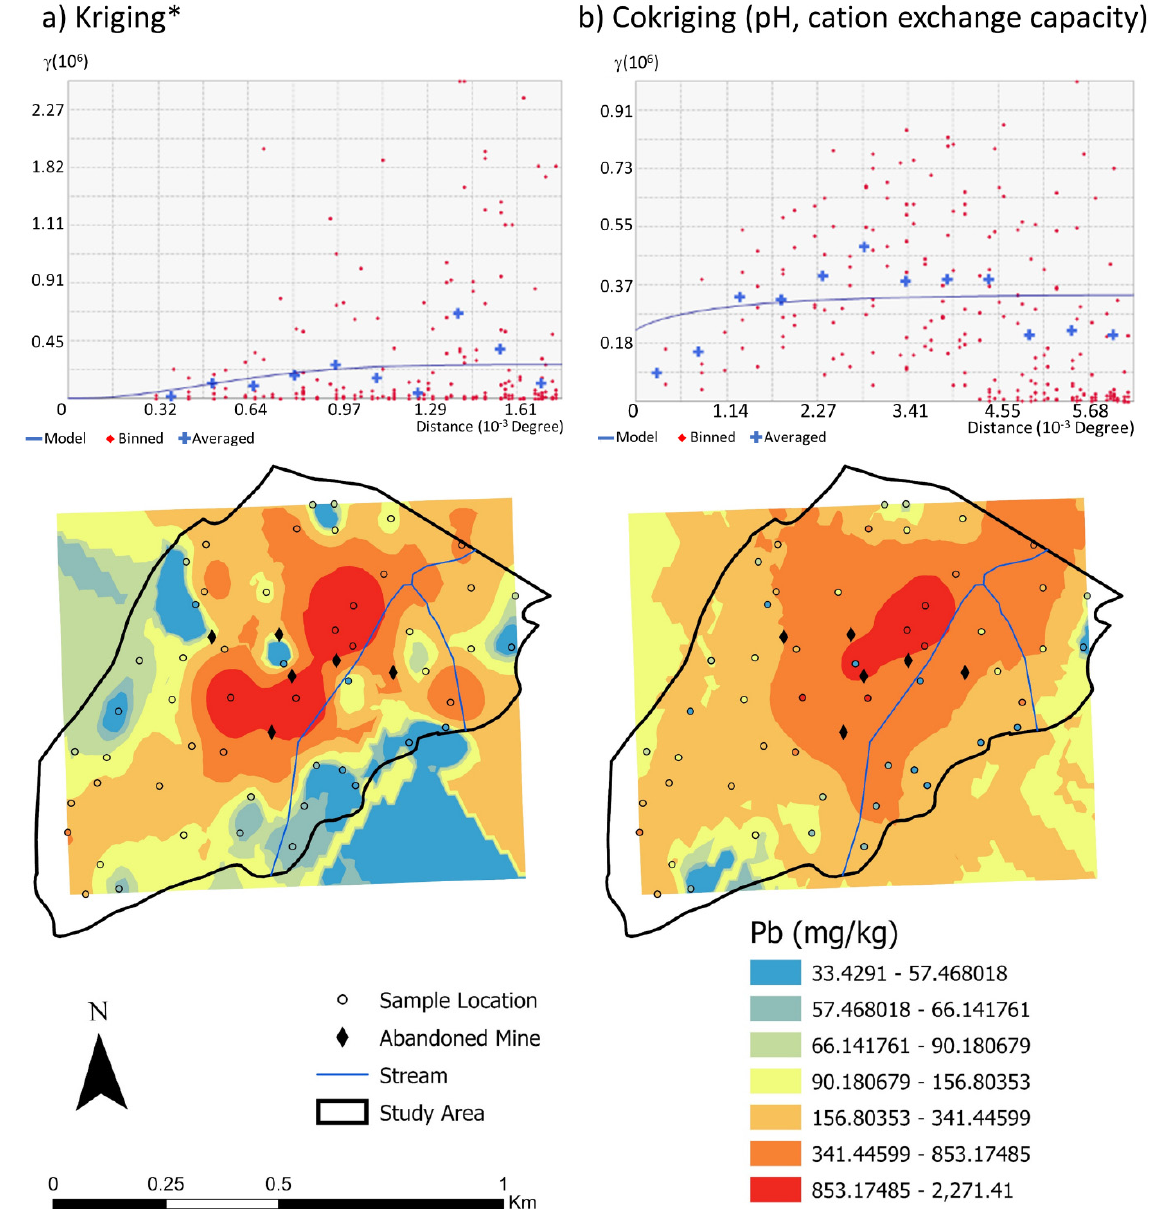
Figure 5. Variograms and interpolated Pb concentration using ordinary kriging ( a ) and cokriging ( b ). Kriging model, marked with an asterisk, was selected as the superior model.